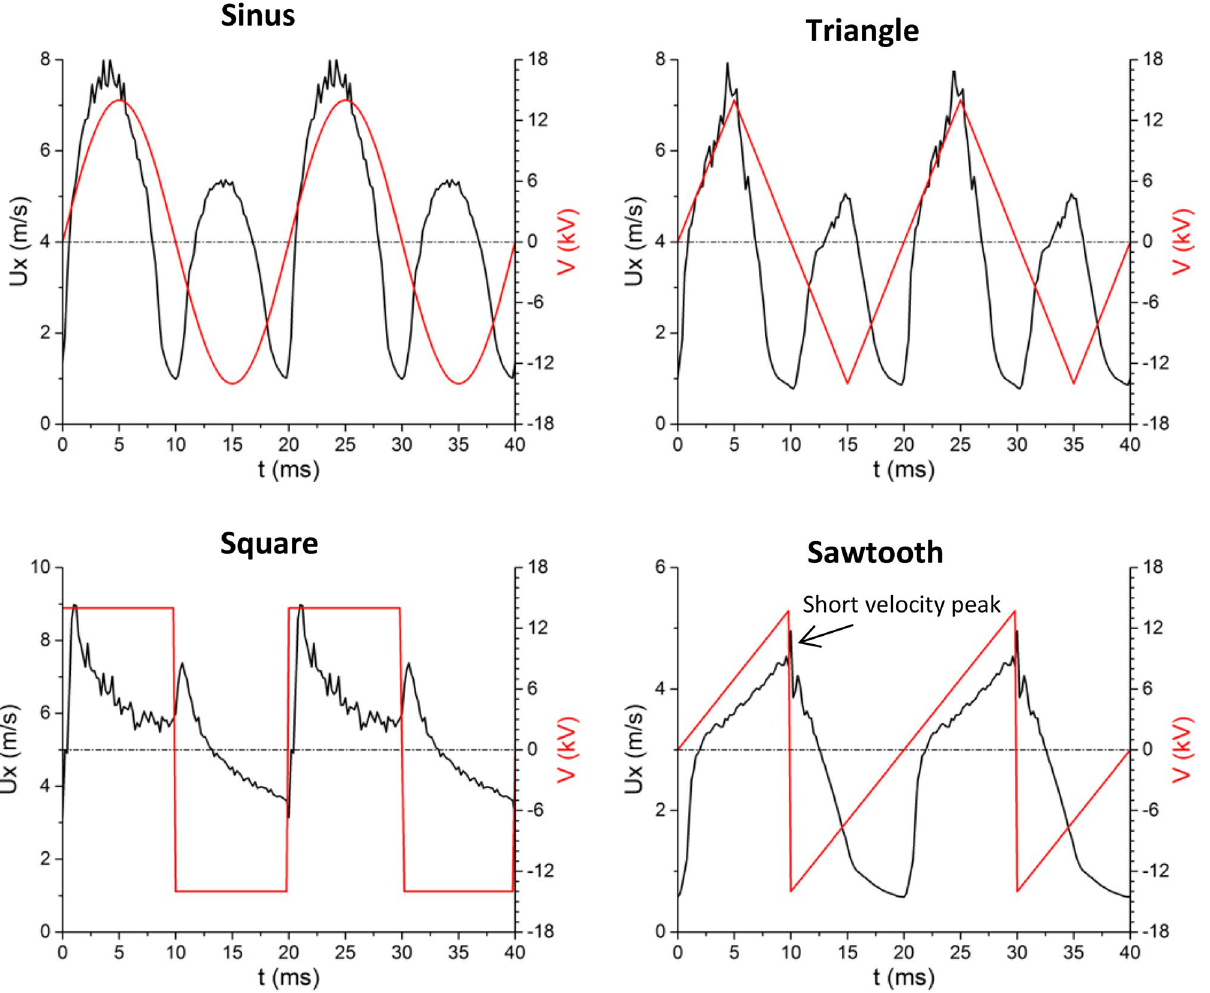
Figure 4. Horizontal component of the instantaneous velocity U x at y = 0 and x = 1.5 mm versus time for the four different voltage waveforms (V AC = 14 kV and f AC = 50